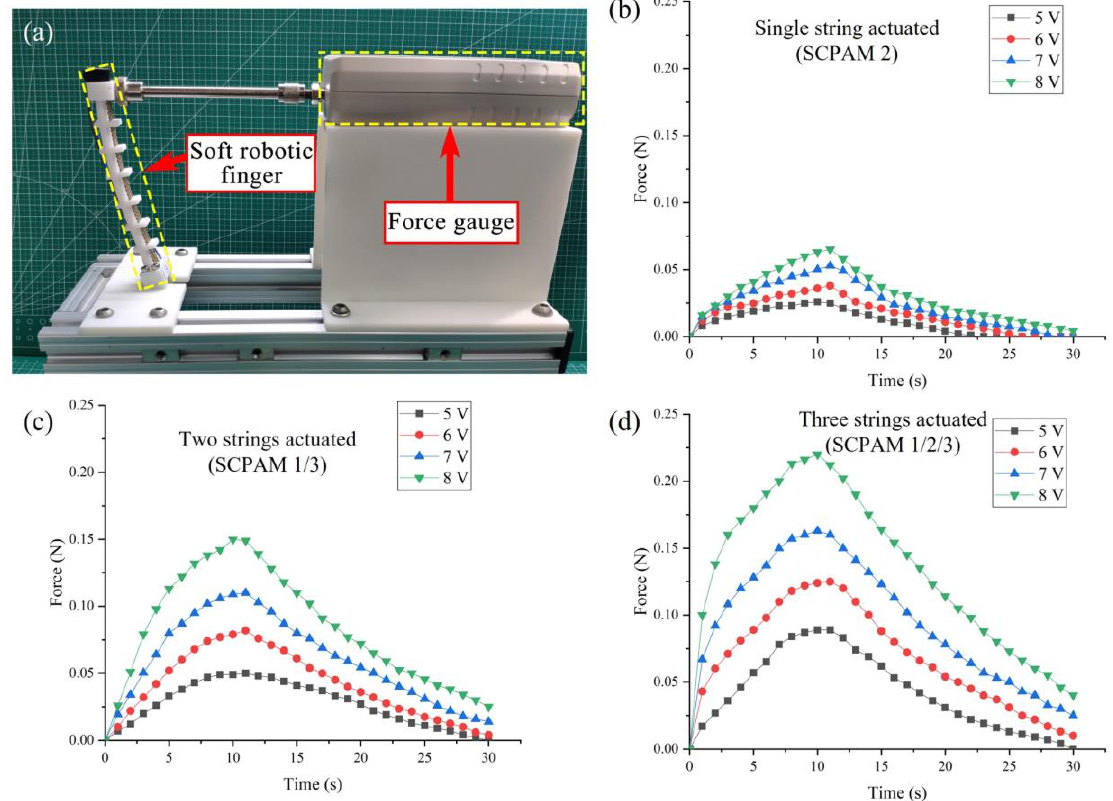
Figure 10. Output force test of the string. ( a ) The platform established to test the string’s output force. ( b – d ) The output force of the string’s end for time under different input voltages with the actuation of a single SCPAM string (SCPAM 2), two SCPAM strings (SCPAM 1 and 3), and three SCPAM strings (SCPAM 1–3),